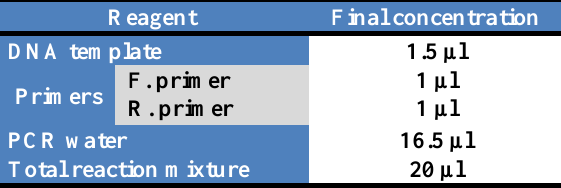
Table, 2: Reaction mixture of DNA amplification.